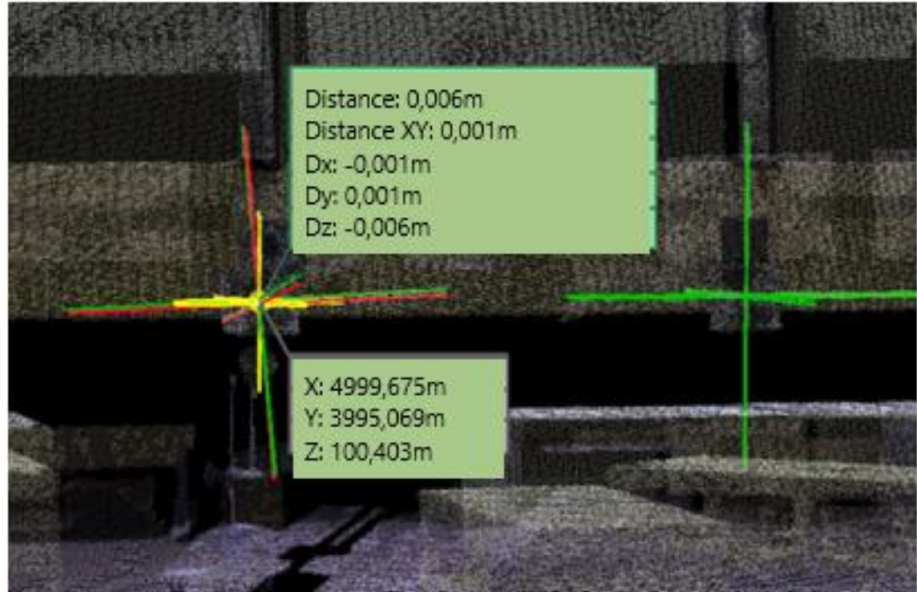
Figure 7. Evaluation of TL_02 beam displacements based on changes in target positions before and after loading.